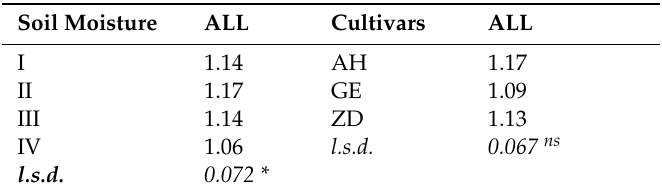
Table 4. Mean fractal dimensions (FD) and fractal abundances (FA) under various soil moisture (See Table 1 for soil moisture abbreviations) and cultivar (AH, GE and ZD) treatments. ** p < 0.01; ns-no significant.